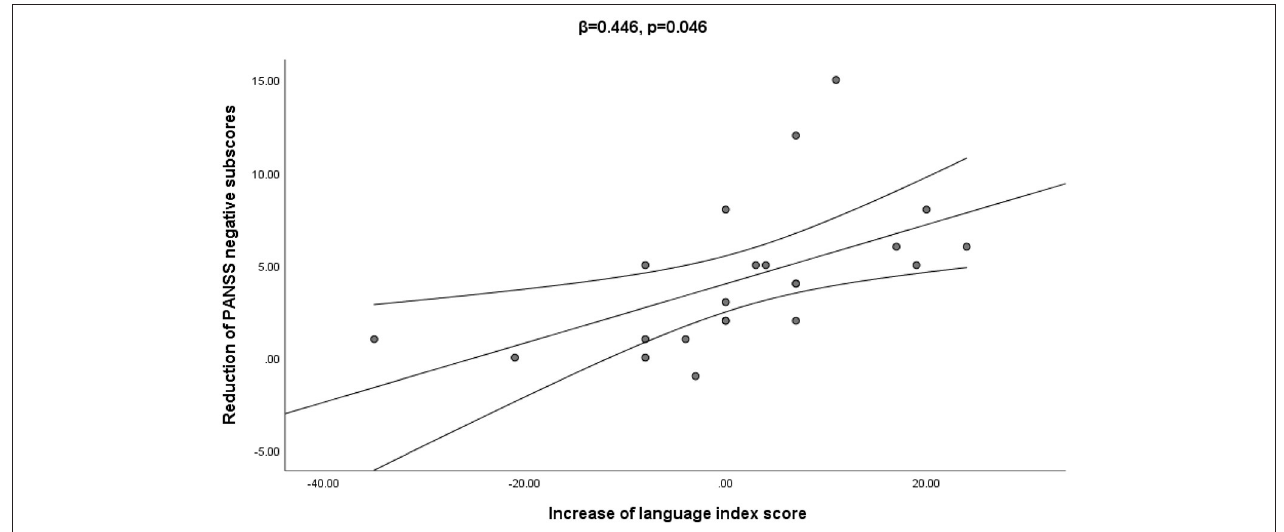
FIGURE 2 | The multiple regression analysis confirmed that the increase in language index score was significantly associated with the decrease of the PANSS negative score from baseline to week 4 ( β = 0.446, p =